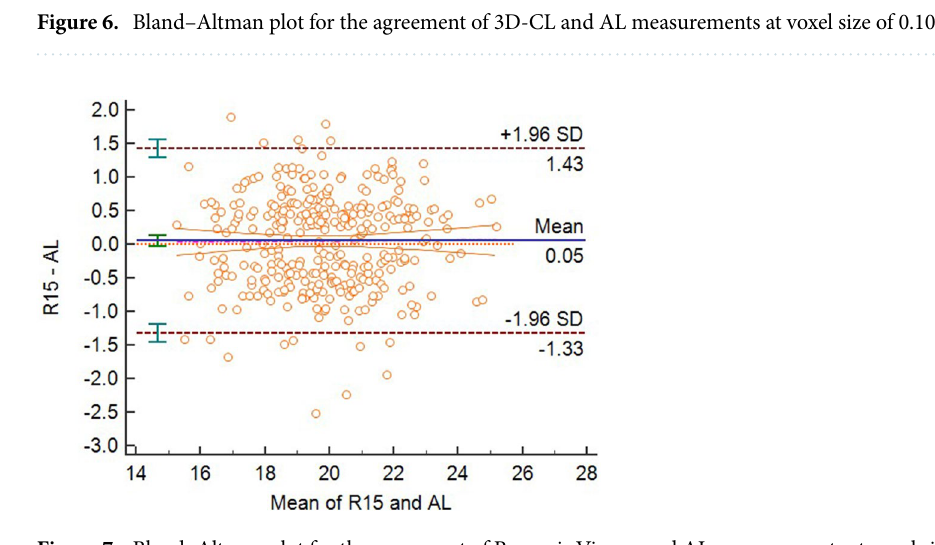
Figure 7. Bland–Altman plot for the agreement of Romexis Viewer and AL measurements at voxel size of